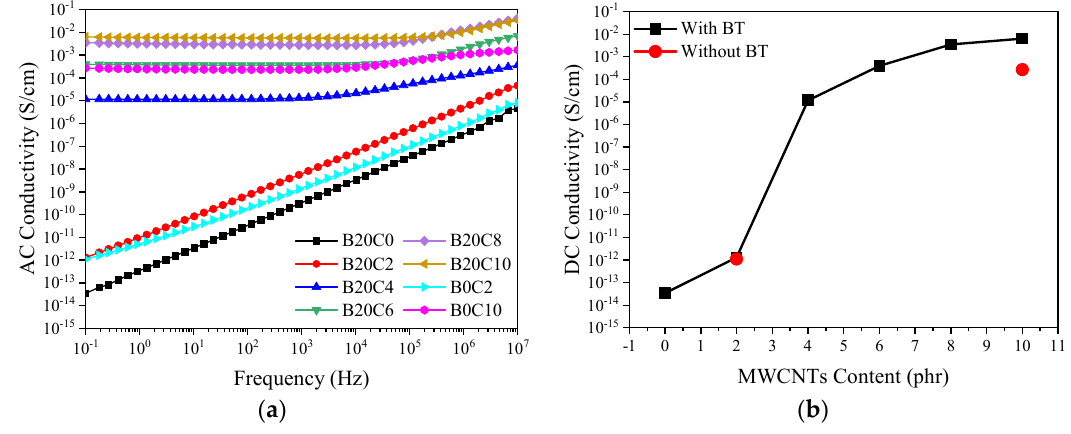
Figure 4. ( a ) AC conductivity ( σ ac) vs. frequency for BT / MWCNTs and MWCNT nanocomposite foams in the frequency region of 10 − 1 to 10 7 Hz; ( b ) DC electrical conductivity of BT / MWCNTs and MWCNTs nanocomposite foams as a function of MWCNTs content.